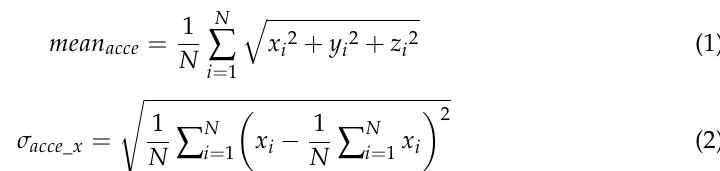
Figure 4. The flow chart of DT-based classification for normal walking, stationary stepping, and lateral walking.